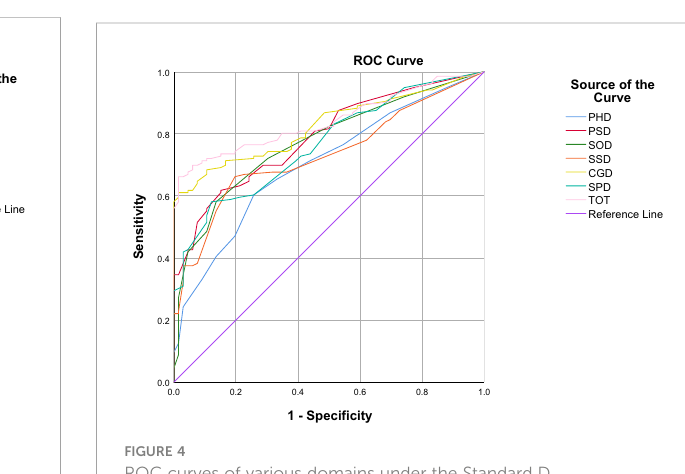
FIGURE 3 ROC curves of various domains under the Standard